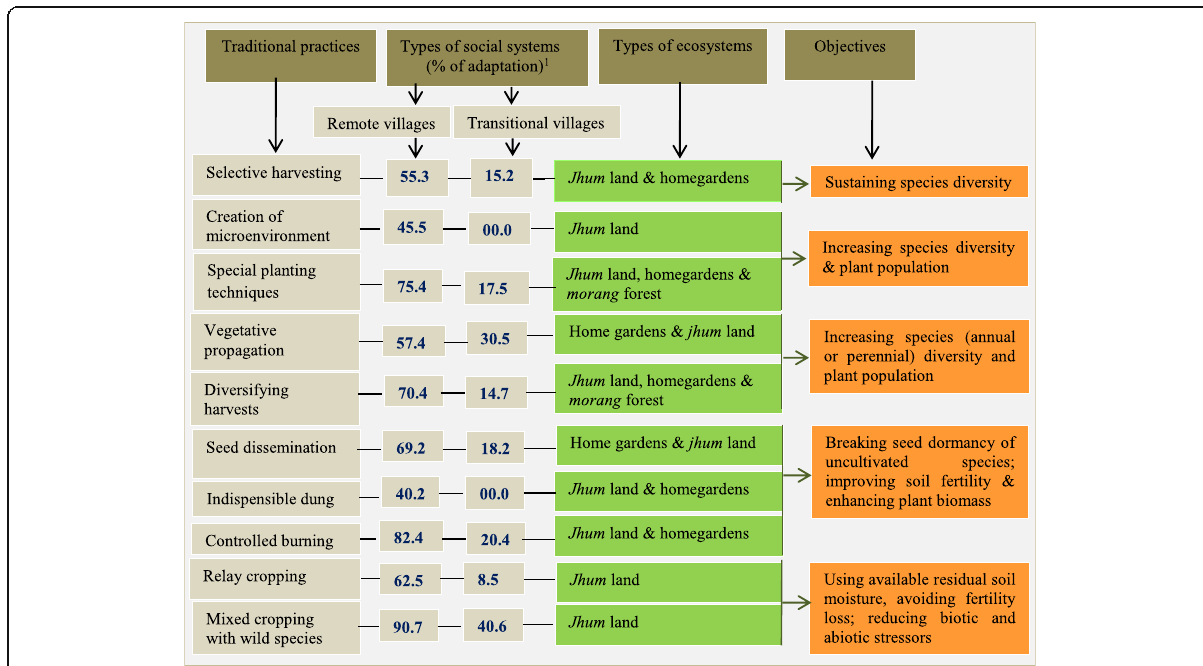
Fig. 5 Traditional agronomic practices adapted by Adi women to enrich plant species diversity and enhance ecological sustainability. 1 Figure is based on pooled data of FGDs conducted in each